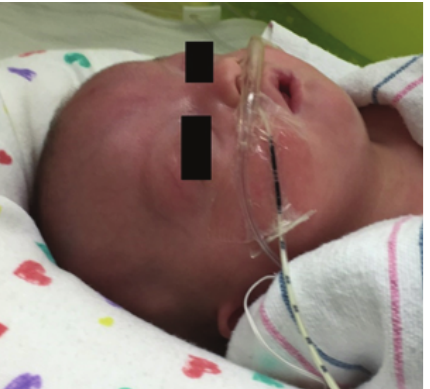
Figure 1: Preoperative image of the patient with Wolf-Hirschhorn syndrome, demonstrating microcephaly and